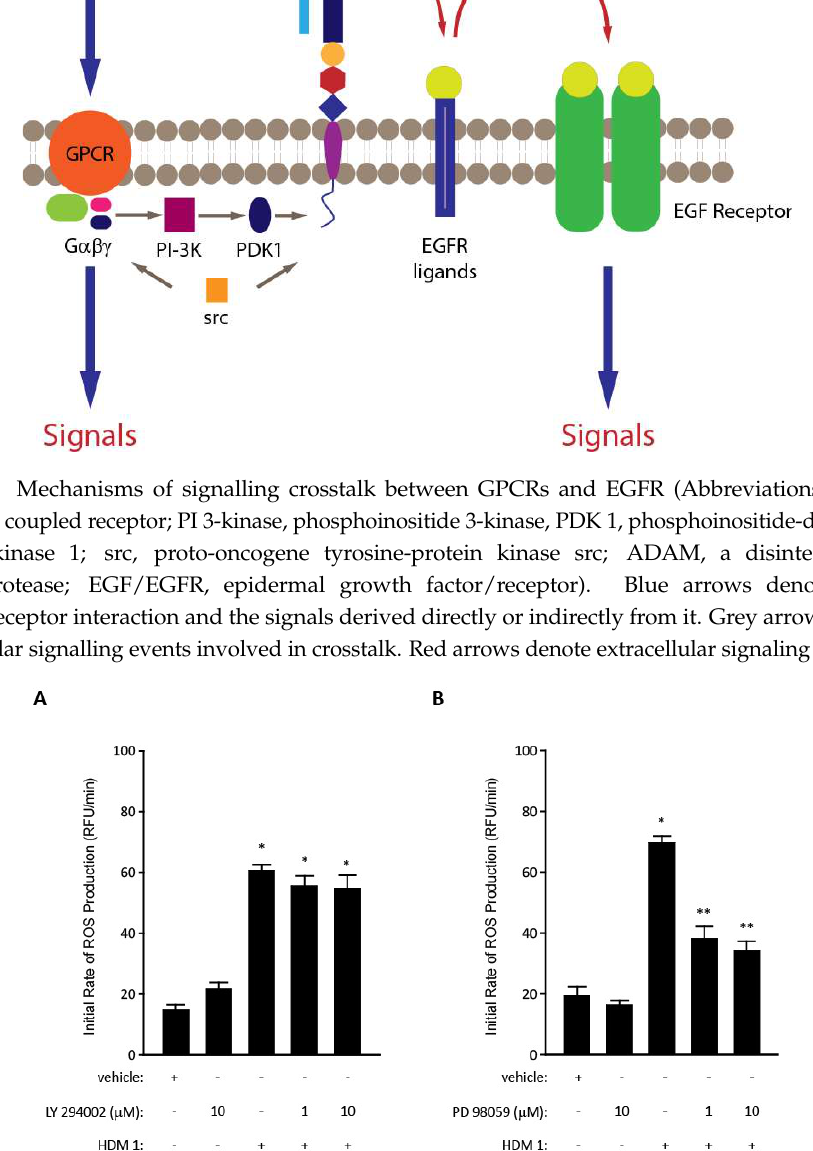
Figure 4. Effects of LY294002 (PI 3-kinase inhibitor) and PD98059 (mitogen activated protein kinase kinase inhibitor) on HDM-allergen stimulation of ROS generation in human airway epithelial cell line Calu-3. Data are shown as mean ± standard error values ( n = 8). * p < 0.001 vs vehicle controls; ** p < 0.001 vs allergen-activated cells (1-way ANOVA with post-hoc testing by Student Newman Keuls procedure). The ROS production was quantified in cells loaded with dihydrorhodamine 123 as described in